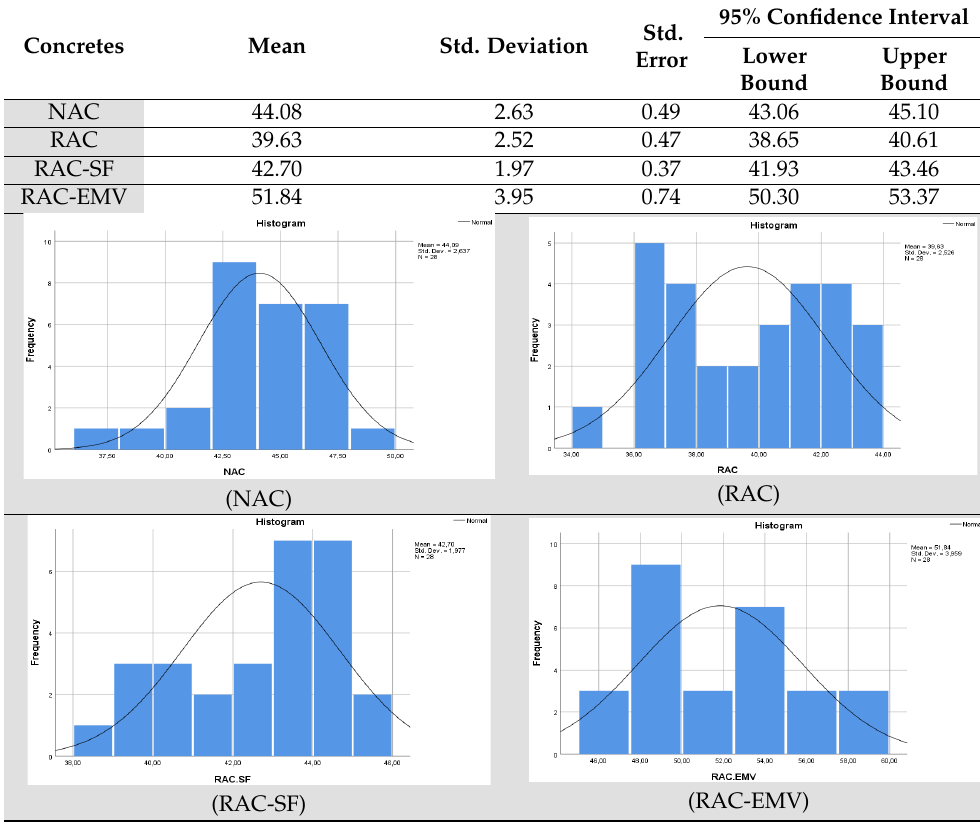
Table 7. Statistical parameters for concretes (with histograms).